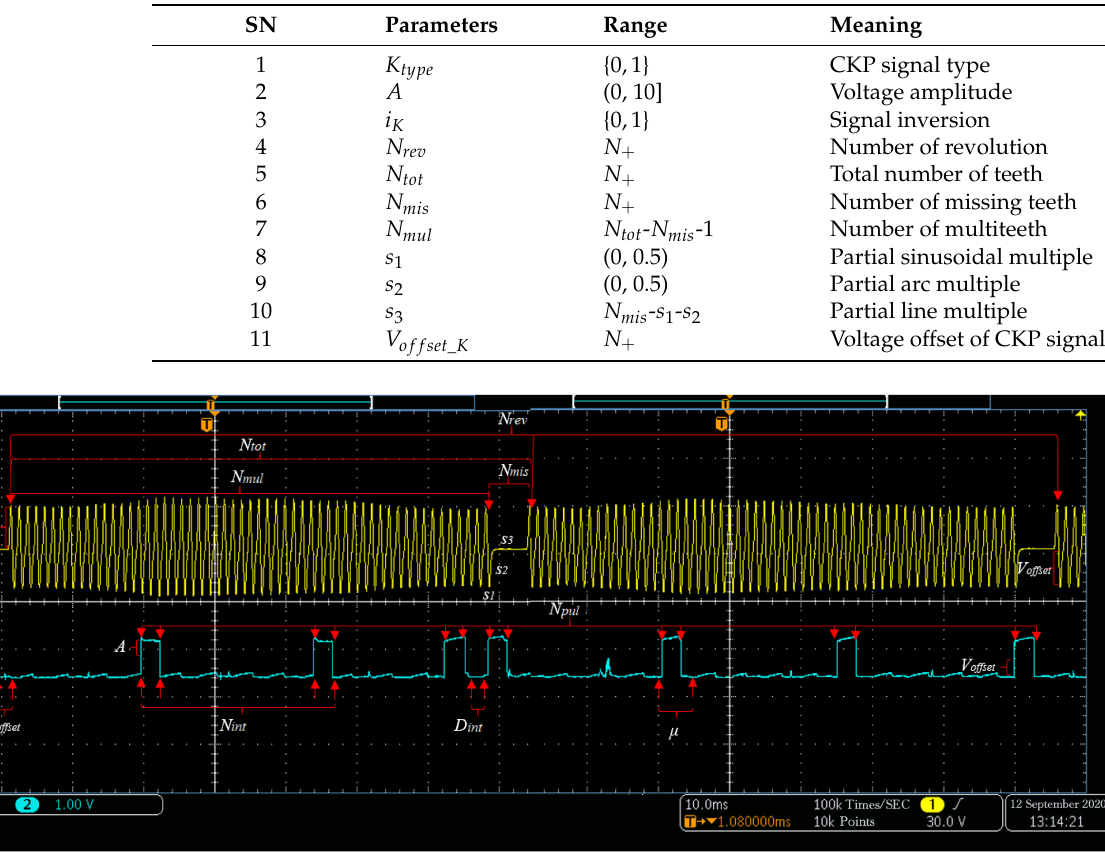
Table 1. CKP signal characteristic parameters.